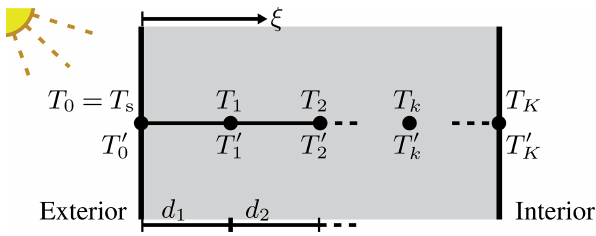
Figure 5. Grid layout used to model conductive heat